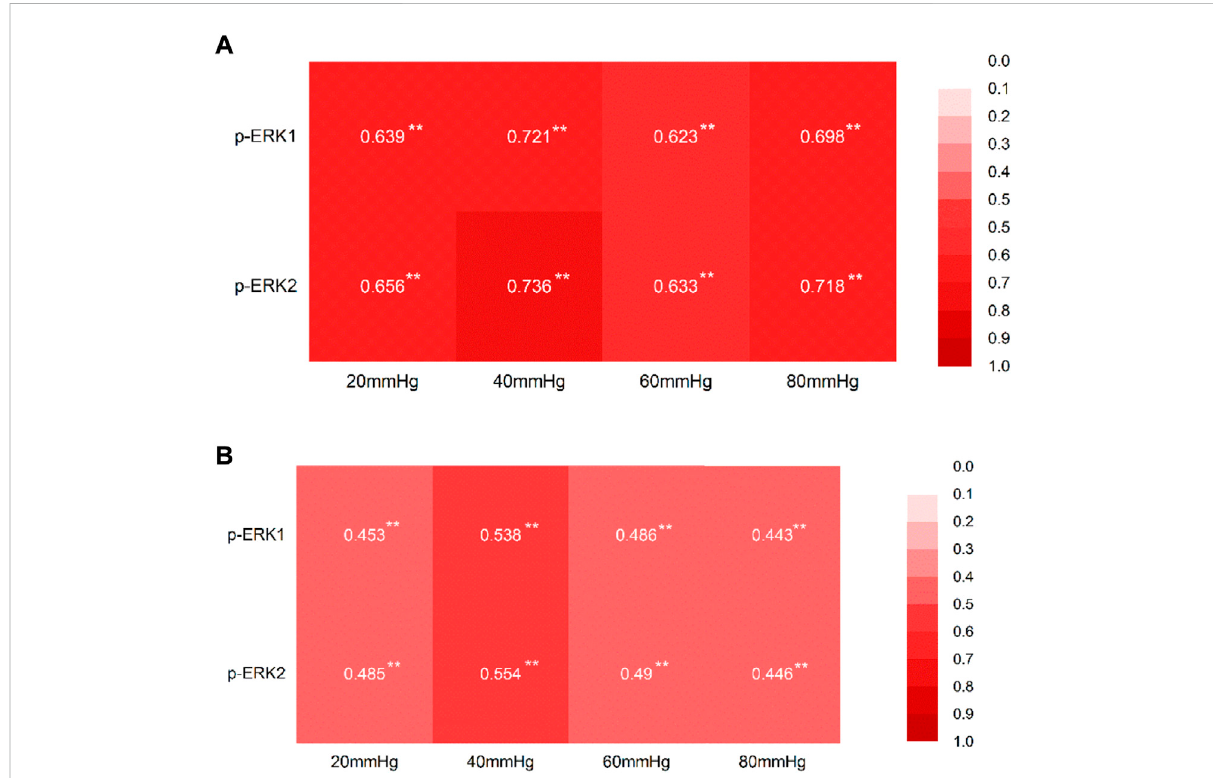
FIGURE 9 Correlation between the AWR score at each pressure level and the expression of p-ERK1/2. (A) Correlation between the AWR score at each pressure level and the expression of p-ERK1/2 in the tissue of the colon, with the correlation coef fi cient. (B) Correlation between the AWR score at each pressure level and the expression of p-ERK1/2 in the tissue of the hippocampus, with the correlation coef fi cient. * p < 0.05; ** p <